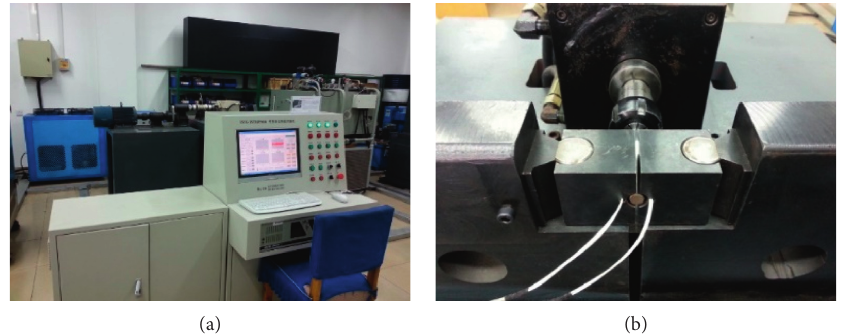
Figure 2: Testing machine and self-lubricating fabric liner under test. (a) Testing machine. (b) Self-lubricating fabric liner under test.